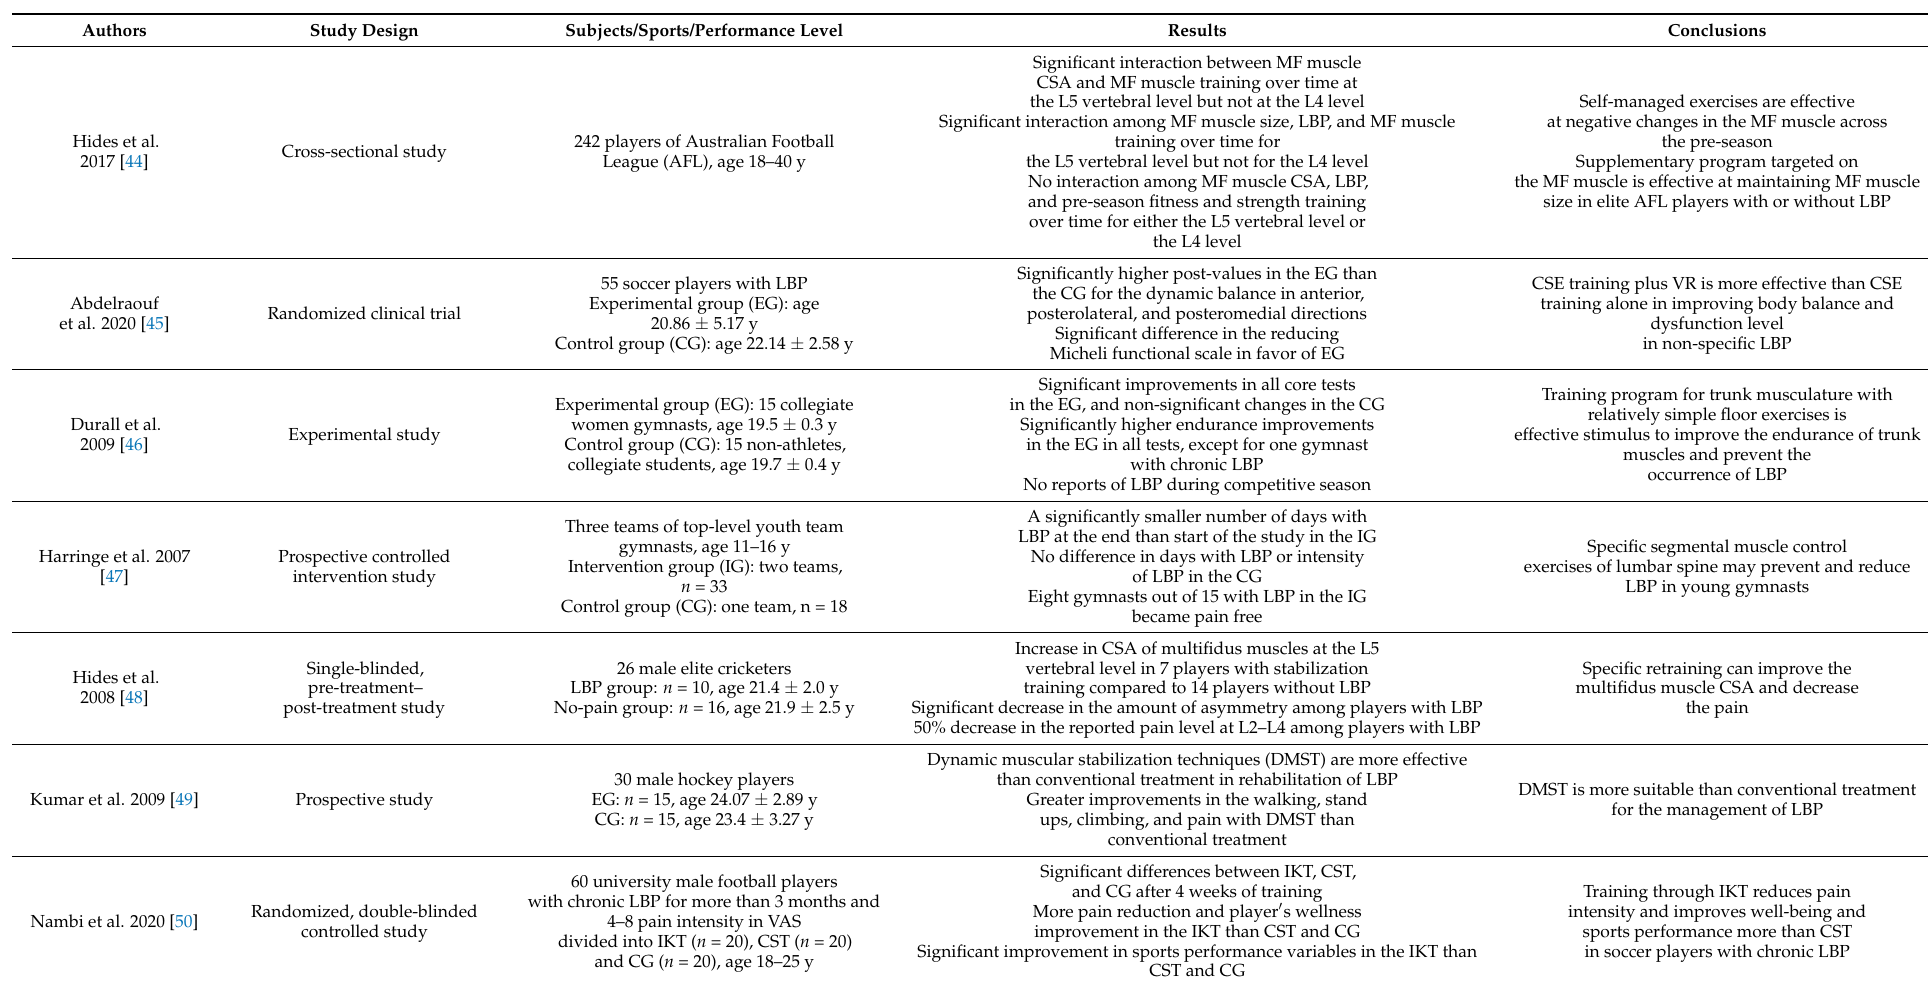
Table 3. Core muscle training and